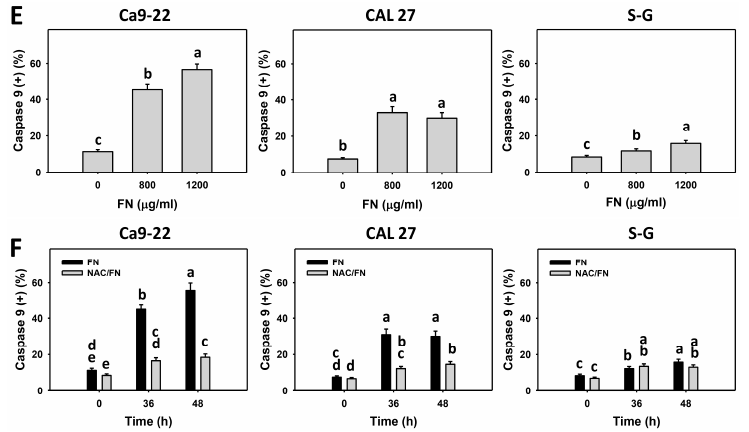
Figure 4. Fucoidan drives Cas 3, 8, and 9 signaling in oral cancer cells. Summary histograms of the flow cytometry results are presented. The individual density plots are presented in Supplementary Figure S1. ( A , C , E ) Cas 3, 8, and 9 statistical analysis. Oral cancer (Ca9-22 and CAL 27) and non- malignant cells (S–G) were treated with fucoidan (control, 800, and 1200 μg/mL) for 0 and 48 h. (+) indicates a high level of Cas 3, 8, and 9. ( B , D , F ) The effect of oxidative stress on Cas 3, 8, and 9 activations of fucoidan-incubated oral cancer cells. After NAC preincubation or not, cells were treated with fucoidan (1200 μg/mL) with NAC co-treatment (10 mM) for 0, 36, and 48 h. NAC/fucoidan (NAC/FN) represents the pretreatment with NAC and post-treatment with FN. Data = mean ± SD ( n = 3 experiments). Data with non-overlapping letters reveal significant differences ( p < 0.05). In the example of Figure 4B (Ca9-22 cells), FN at 36 and 48 h labeled with “a” has significant results compared with that at 0 h labeled with “bc”, because the letters do not overlap. FN and NAC/FN at 36 and 48 h labeled with “a and bc” and “a and b” have significant results. In contrast, FN at 36 and 48 h labeled with “a” has nonsignificant results because the letters overlap. e is not appeared for statistic analysis in the